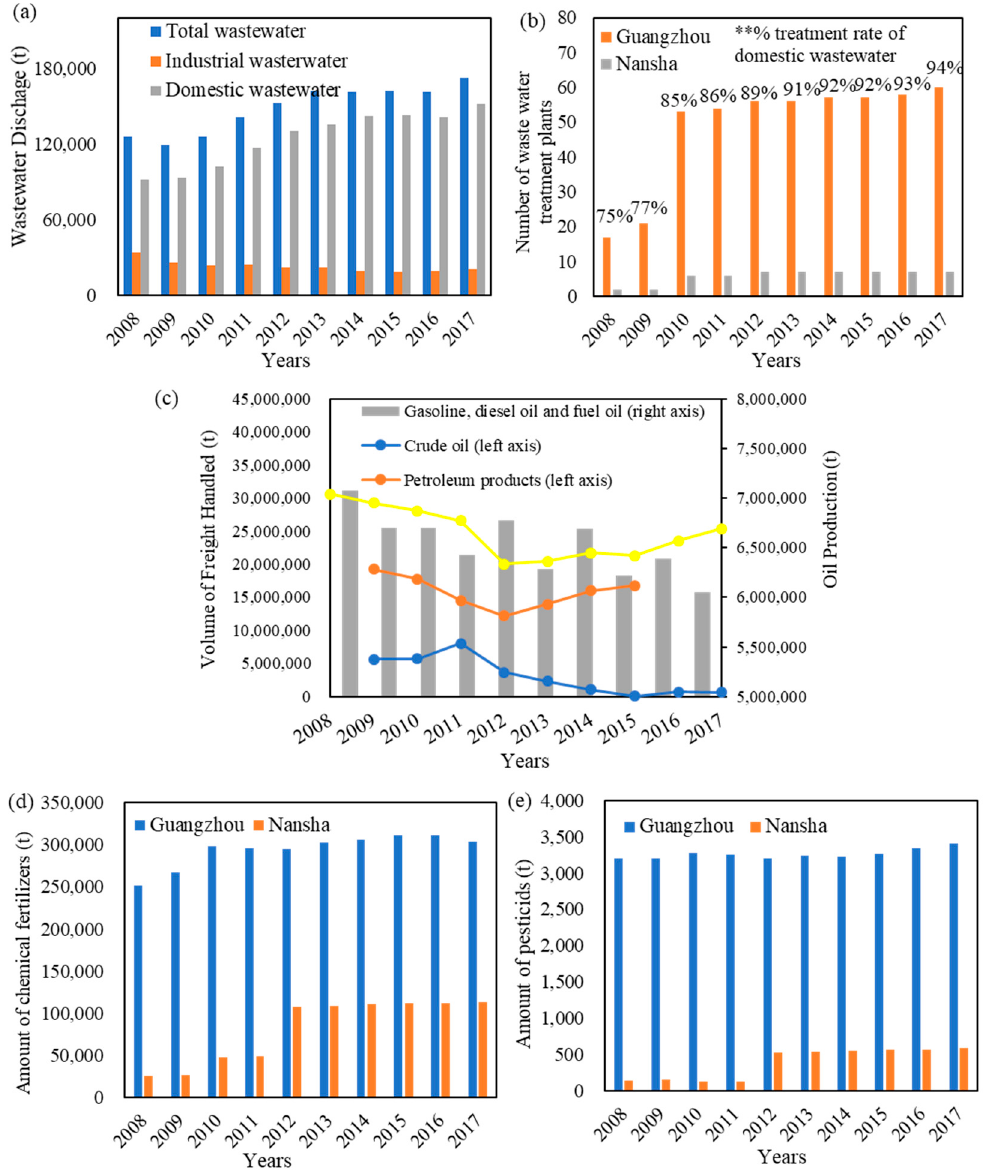
Figure 6. The situation of wastewater discharge ( a ), wastewater treatment plants ( b ), volume of oil freight handled and production ( c ), application of chemical fertilizers, ( d ) and usage of pesticides ( e ) in Guangzhou from 2008 to 2017 [49,50].